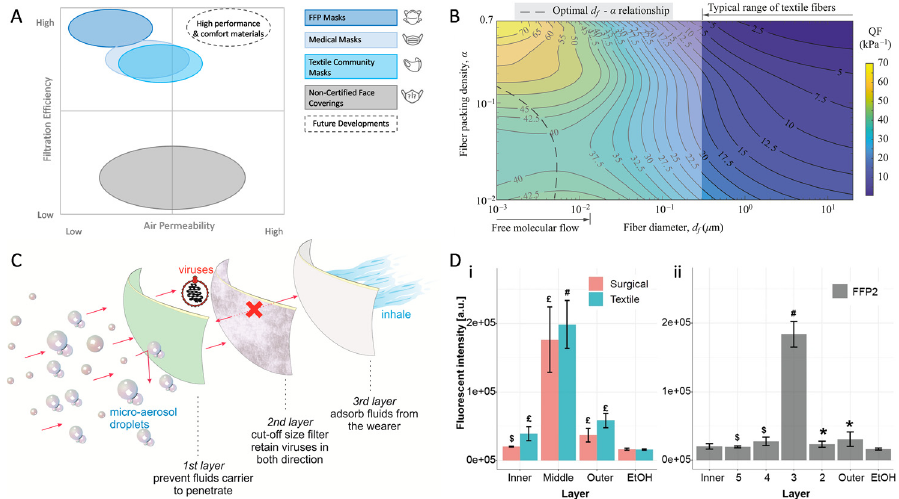
Figure 1. Filtration efficiency and air permeability as driving factors for community mask development. Categorization of face mask types ( A ) [15], air permeability limited by fiber architecture ( B ) [25], the established layer structure of community masks with nanofibrous non-woven fabrics as a filter ( C ) [20], and viral distribution per layer after simulated use in common face mask types ( D ) [36]. ( A , B , D ) Reproduced under CC BY 4.0 ( C ) Reproduced with permission from the American Physical Society.